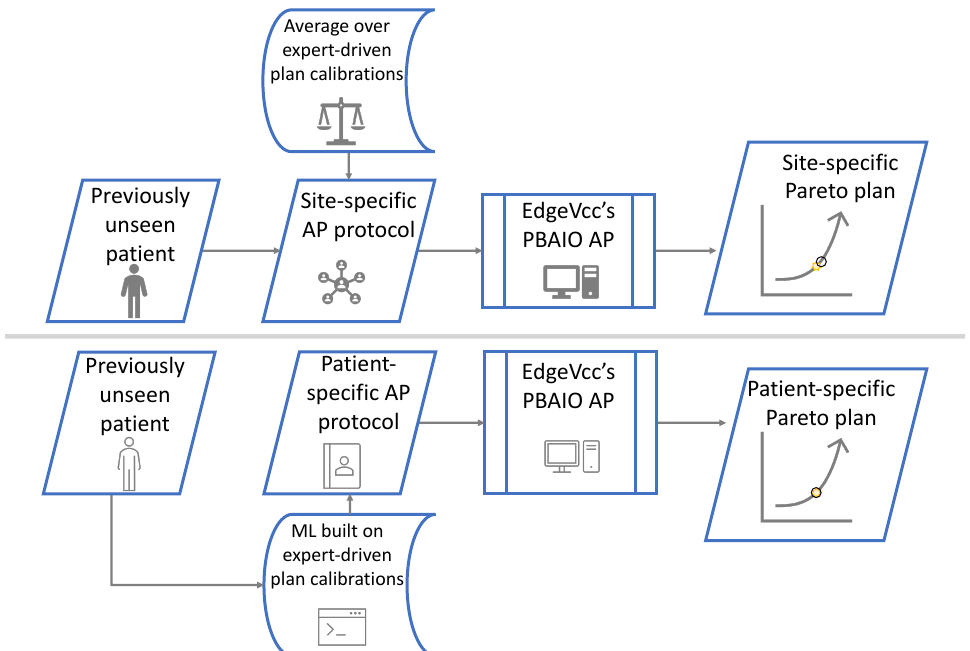
Figure 1. An outline of how the KBP-RBP process defined in this work ( bottom ) differs from the more classic site-specific methods ( top ). Classic approaches define a single site-specific template applied to all treatment cases. In this work, a ML approach is defined that achieves a patient-specific planning template based on patient